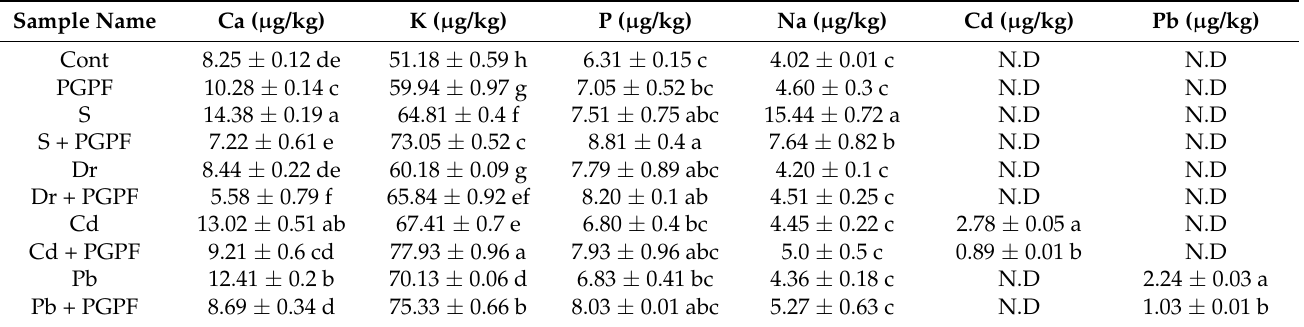
Table 2. Calcium (Ca), potassium (K), phosphorus (P), sodium (Na), cadmium (Cd) and lead (Pb) contents in tomato plants grown under stress and control conditions with or without PGPF after 10 days of